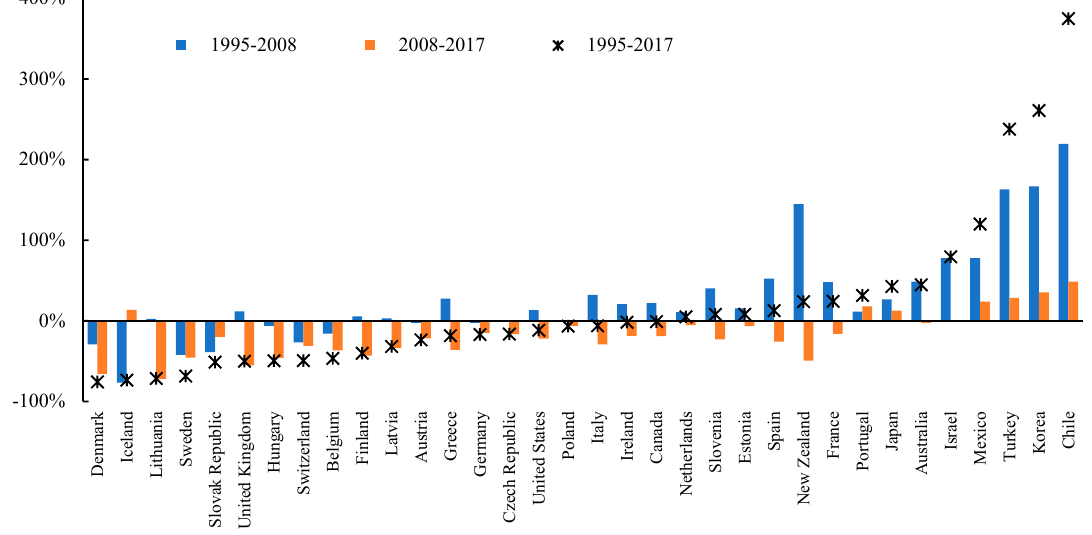
Figure 3. CO 2 emission growth rate of power sector in OECD countries, 1995–2017 and sub-periods. 1 . 194 However, for most of the EU countries who have pursued carbon-free policies, the CO 2 emission from the power sector either decreased or was maintained at 10% level, greatly contributing to the CO 2 reduction e ff ort of OECD countries. During the 1995–2017 period, the European countries